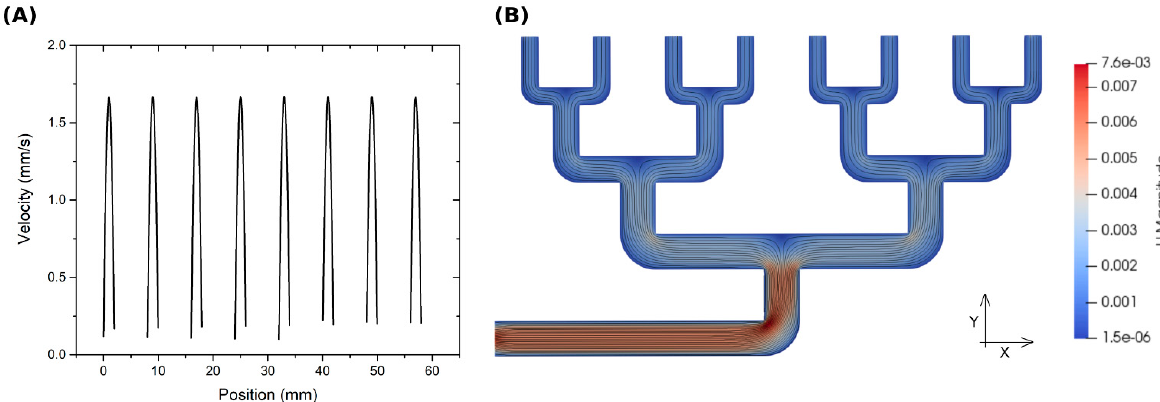
Figure 3. The result of a numerical simulation showing the speed ( A ) at which the spinning solution flowed out of the individual distribution chambers ( B ) in the needleless nozzles used in this study. One of four segments